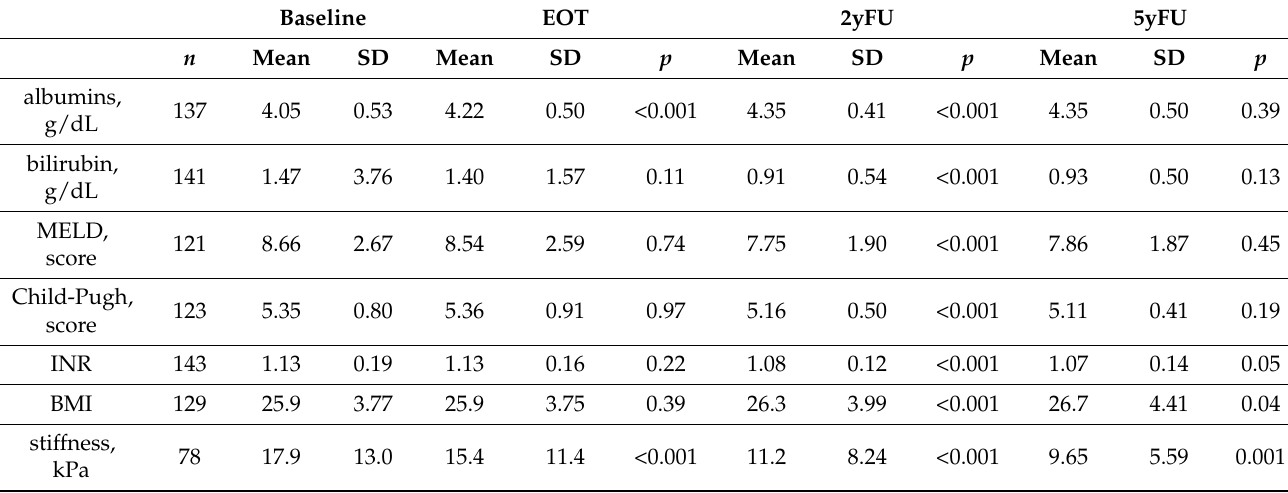
Table 4. Mean values of selected measures at the baseline, end of treatment (EOT), after 2 years follow-up (2yFU) and 5 years of follow-up (2yFU).